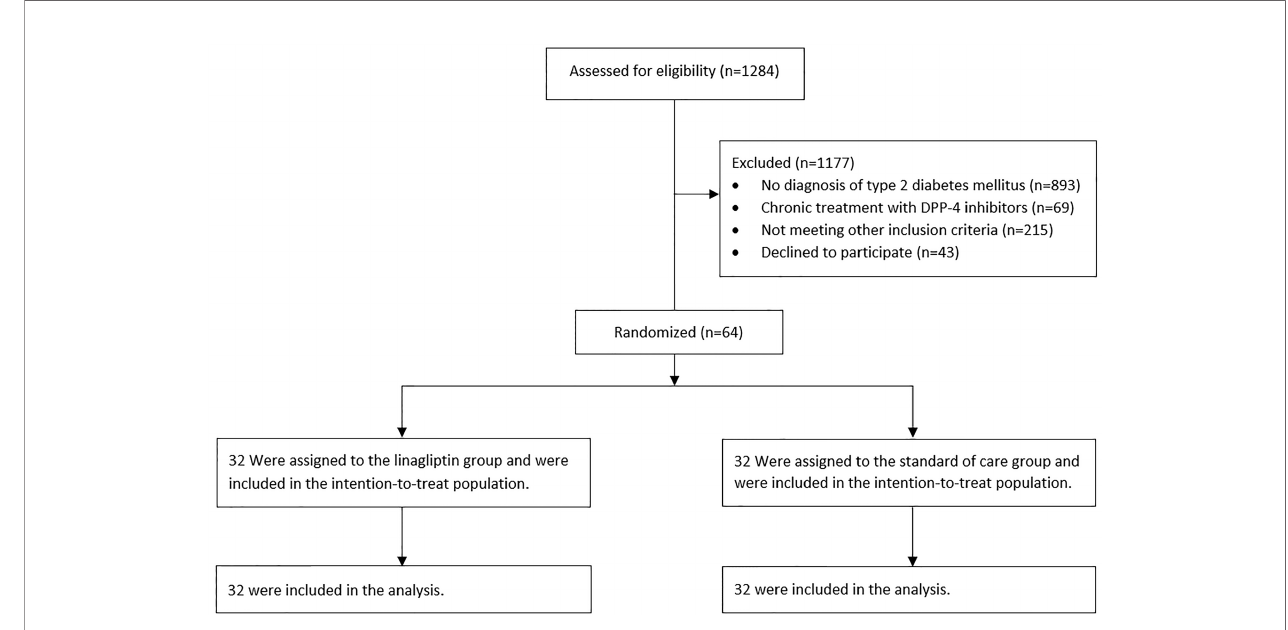
FIGURE 1 | Flowchart of the